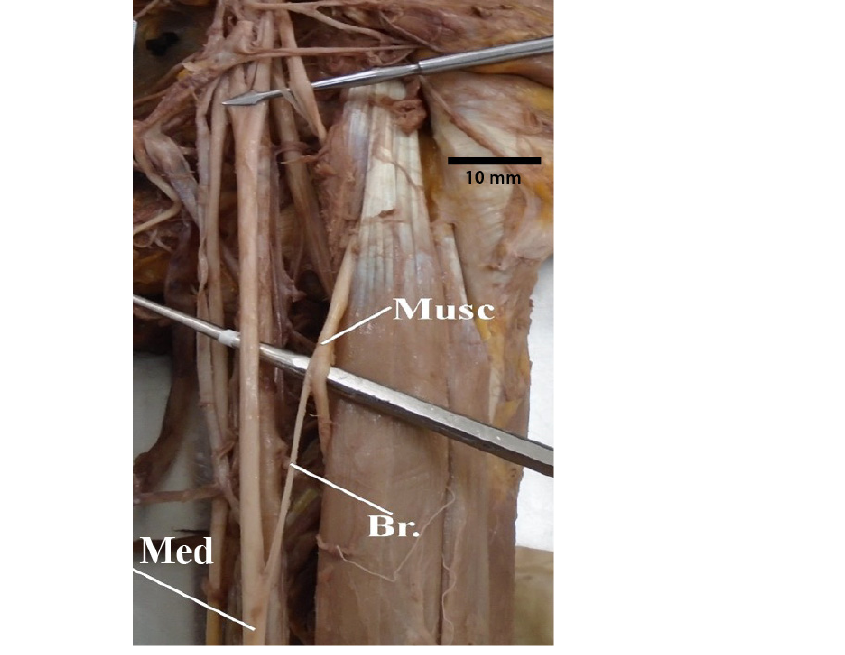
Figure 13. Photograph of the median nerve receiving branches from the musculocutaneous nerve. Abbreviations: Br. = branch from musculocutaneous nerve to median nerve; Med = median nerve; Musc = musculocutaneous nerve.